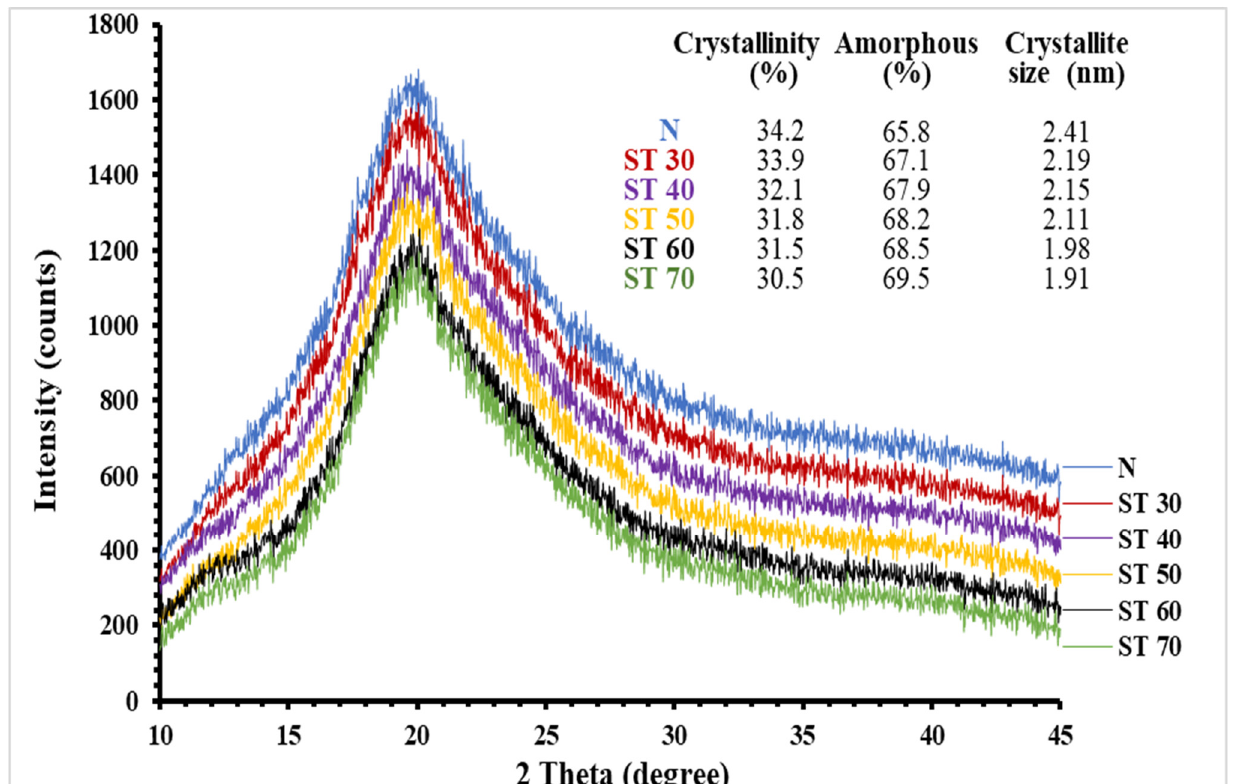
Figure 4. XRD of N: native plum kernel protein isolate; ST 30: supercritical carbon dioxide (SC-CO 2 )- treated plum kernel protein isolate at 30 °C; ST 40: SC-CO 2 -treated plum kernel protein isolate at 40 °C; ST 50: SC-CO 2 -treated plum kernel protein isolate at 50 °C; ST 60: SC-CO 2 -treated plum kernel protein isolate at 60 °C and ST 70: SC-CO 2 -treated plum kernel protein isolate at 70 °C. Table 1. Effect of SC-CO 2 treatment on dispersibility, least gelation concentration, and water activity (a w ) of PKPIs.